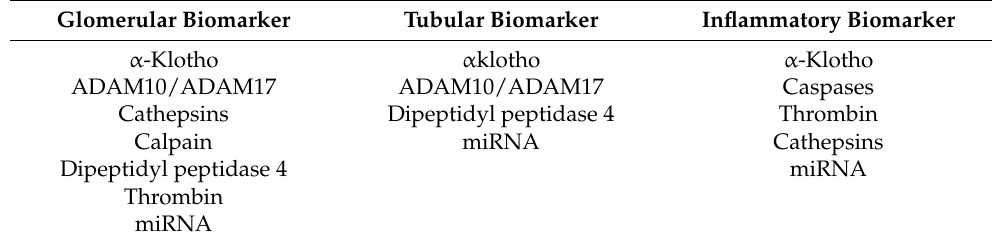
Table 2. Classification of biomarkers, according to the localization and